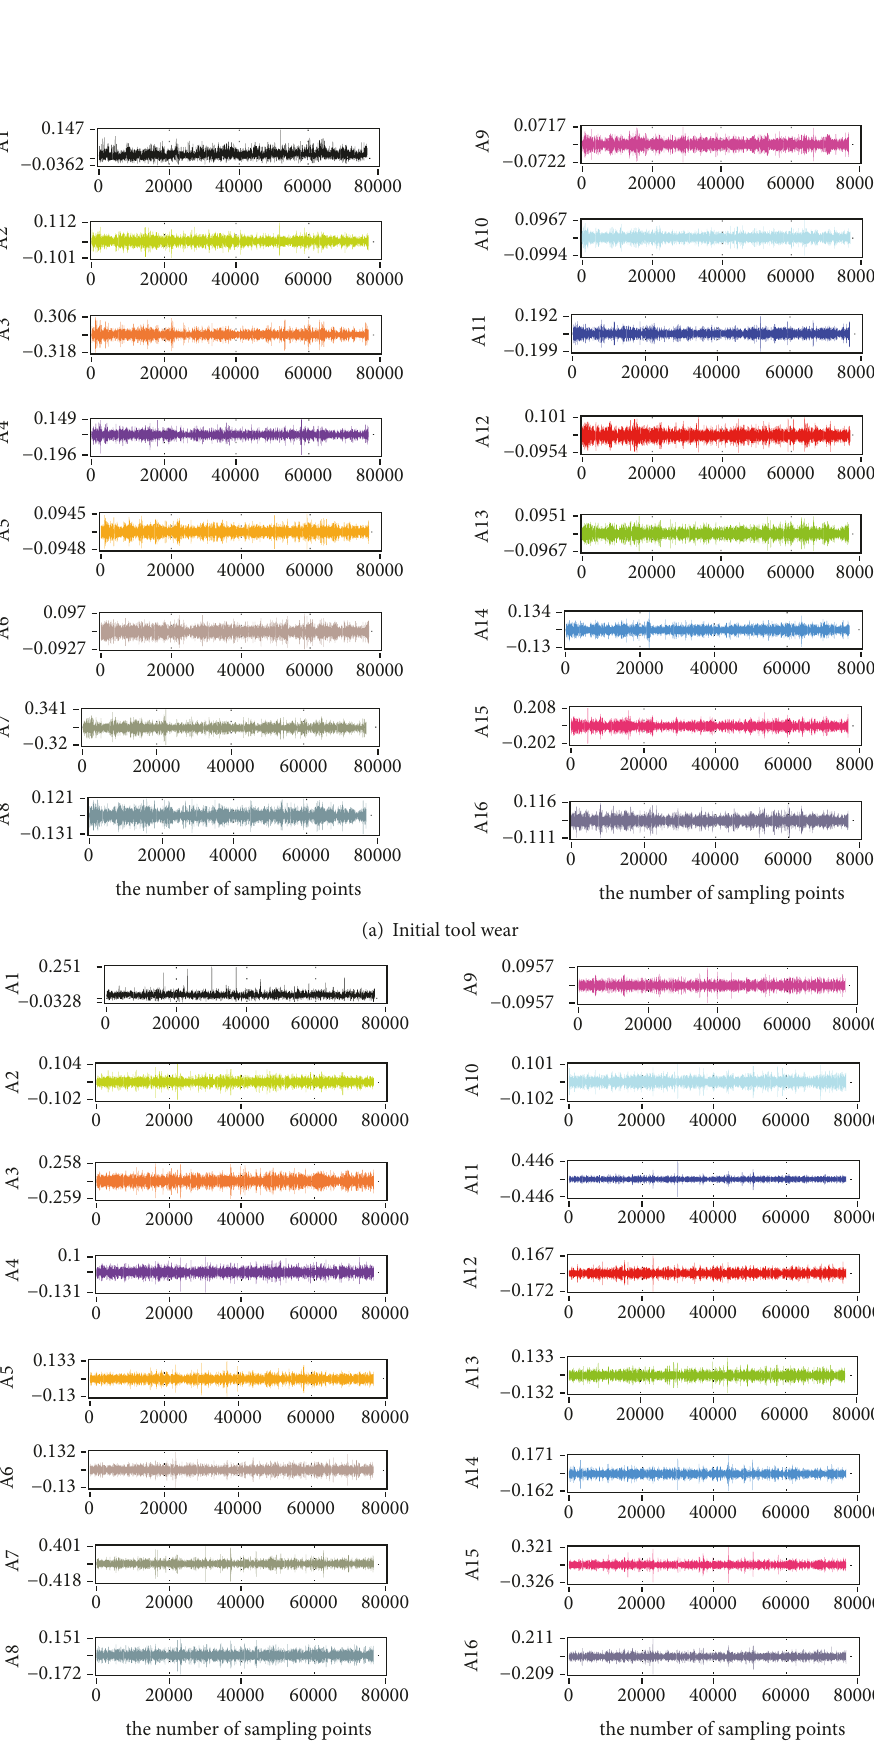
(b) Normal tool wear Figure 14: